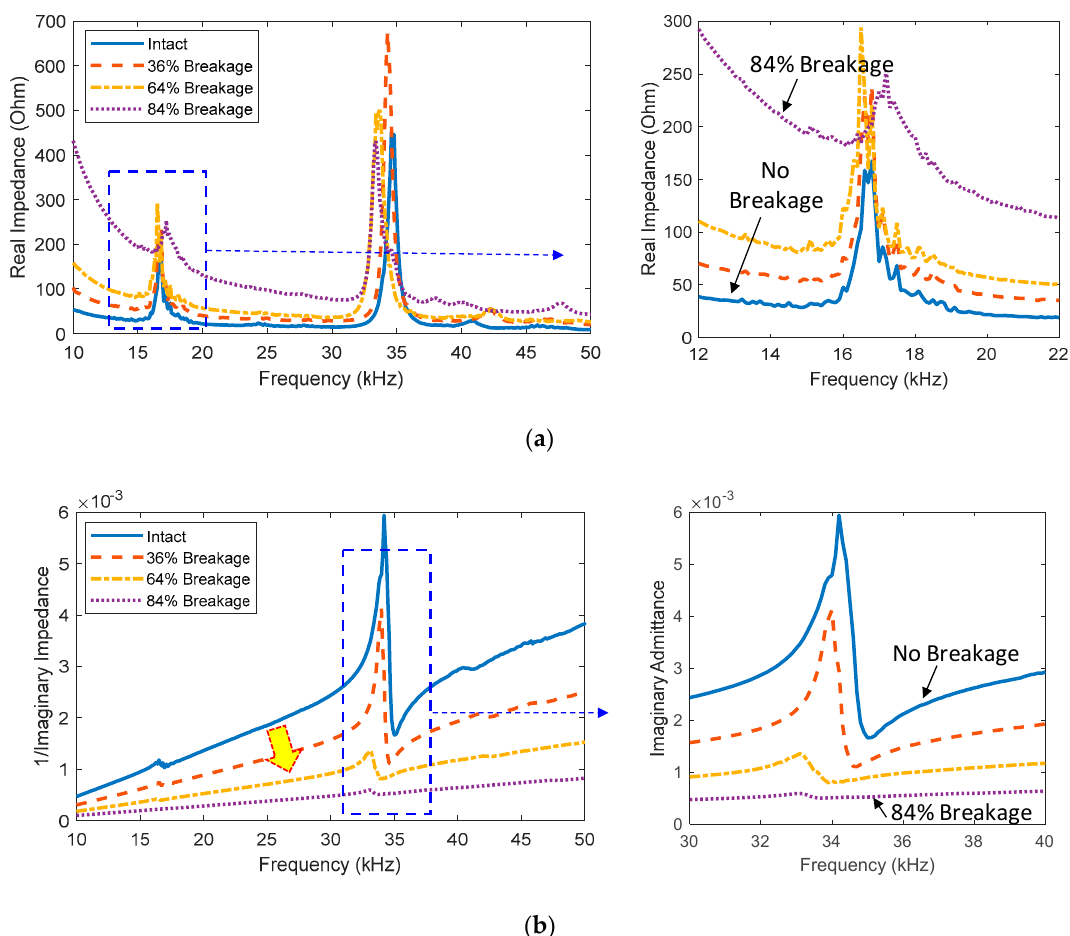
Figure 4. Measured impedance signatures under three cases of sensor breakage: ( a ) real part; ( b ) imaginary part.